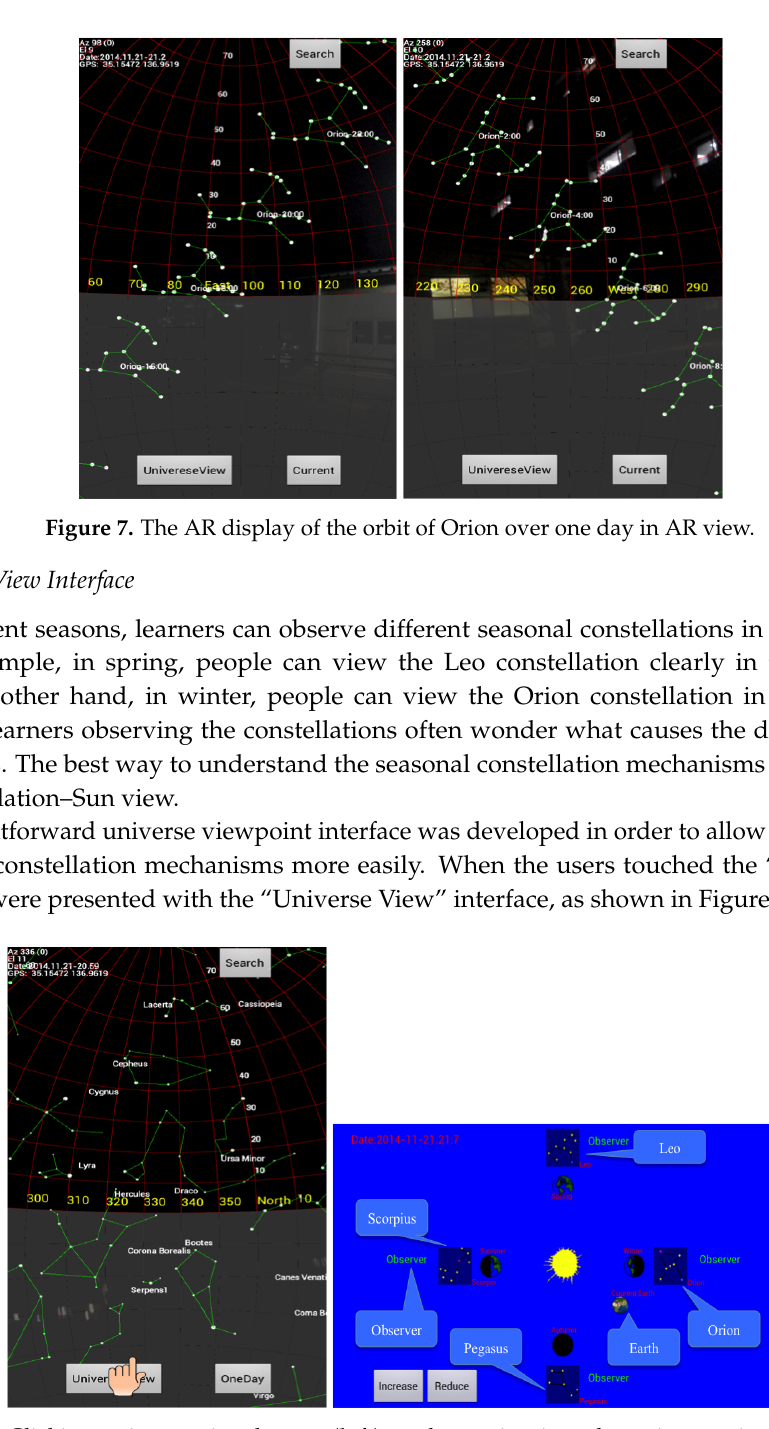
Figure 8. Clicking universe view button ( left ), and stepping into the universe view interface of R-WOSARLS ( right